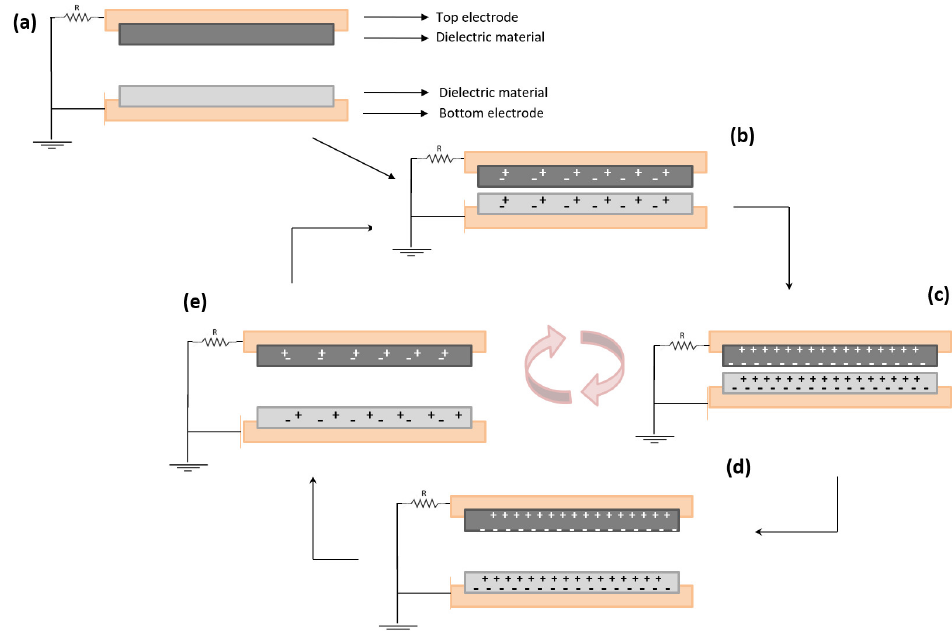
Figure 11. Schematic representation of the working principle of a TENG: ( a ) at the beginning, both dielectric materials are electrically neutral; ( b ) the proximity of the materials causes separation of the charges due to the electrical attraction/repulsion; ( c ) when the materials are in contact, it is observed that there is the polarization of charges; ( d ) when the materials are coming apart it is observed that there is a potential difference between the dielectrics; ( e ) when separated, both materials go back to the neutral electric